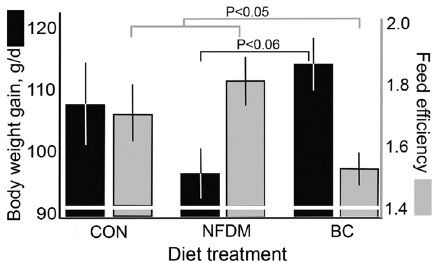
Fig. 1 BC-supplemented diet improved feed efficiency. Mean body weight gain SEM (grams/day) and feed efficiency (grams feed ± consumed per gram body weight gained) in chickens fed the base diet (Control, n 10) or diets supplemented with either nonfat dry = milk (NFDM,